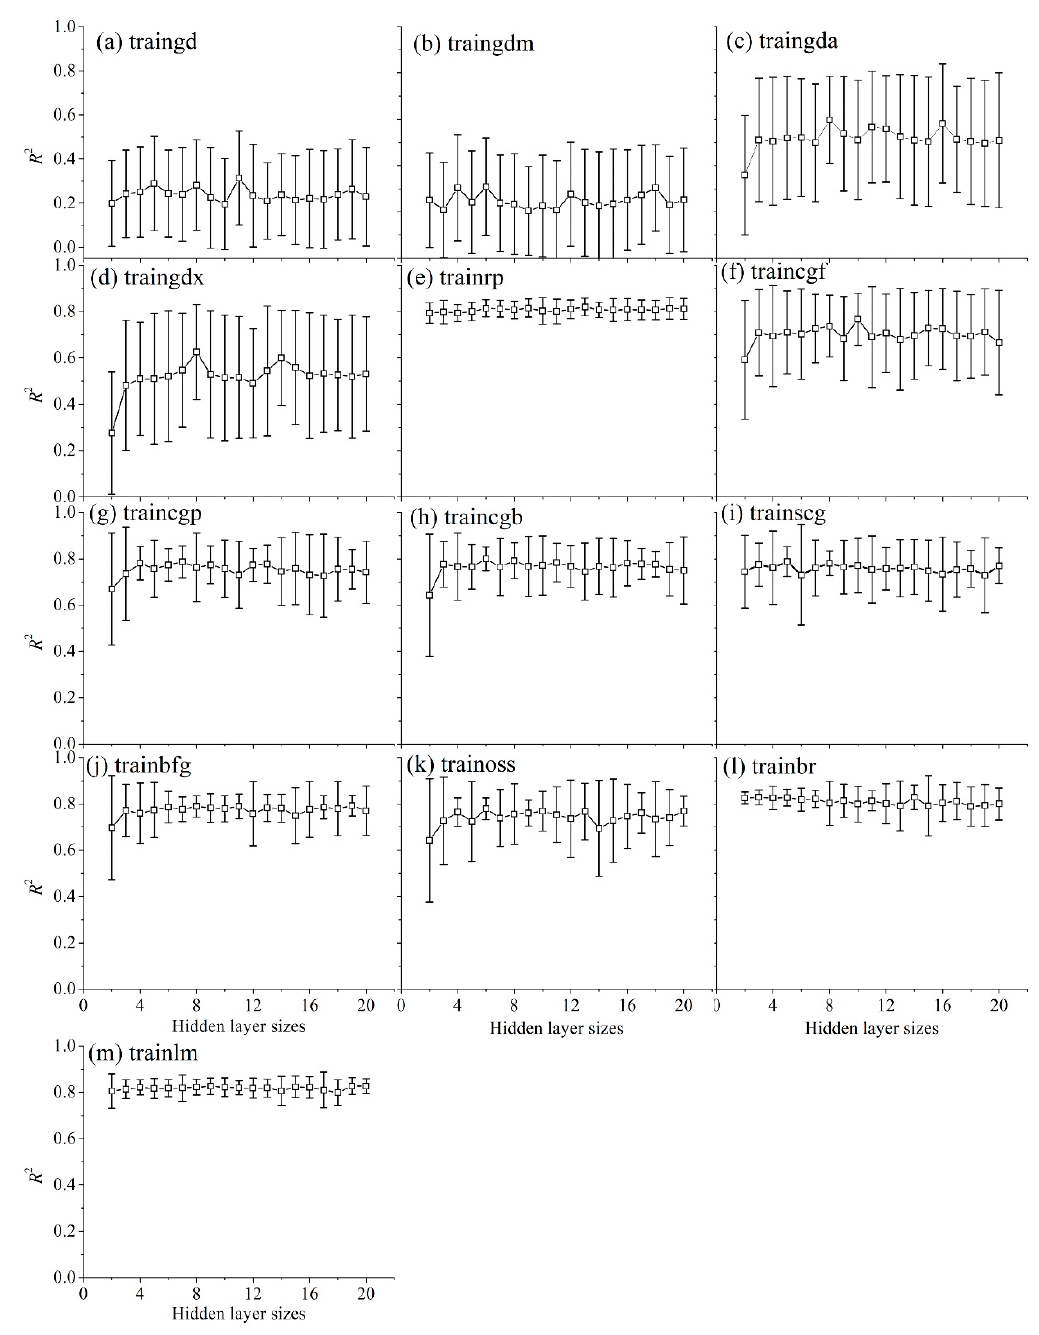
Figure 3. Performance of back-propagation neural network (BPNN) for LNC estimation based on fluorescence characteristics calculated by principal component analysis (PCA) varying with hidden layer sizes for different training functions. The black error bar represents one standard deviation of mean values.